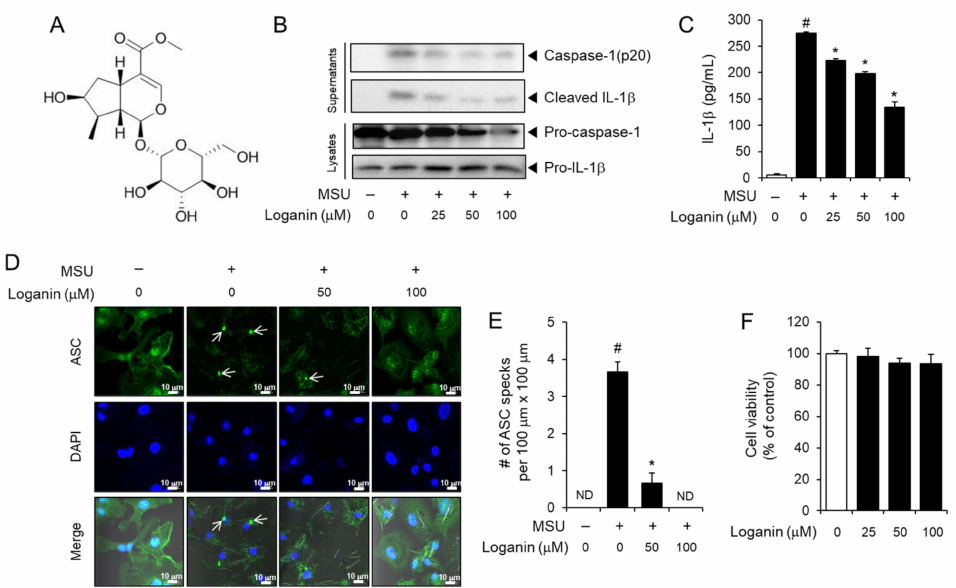
Figure 1. Loganin inhibits monosodium urate (MSU) crystals-induced activation of the NLRP3 inflam- masome in primary macrophages. ( A ) Chemical structure of loganin. ( B – D ) Bone marrow-derived mouse primary macrophages (BMDMs) were primed with lipopolysaccharide (LPS) (100 ng/mL) for 4 h. The cells were treated with loganin for 1 h and then stimulated with MSU crystals (500 µ g/mL) for ( B ) 6 h or ( C – E ) 4.5 h. ( B ) Cell culture supernatants and cell lysates were analyzed by